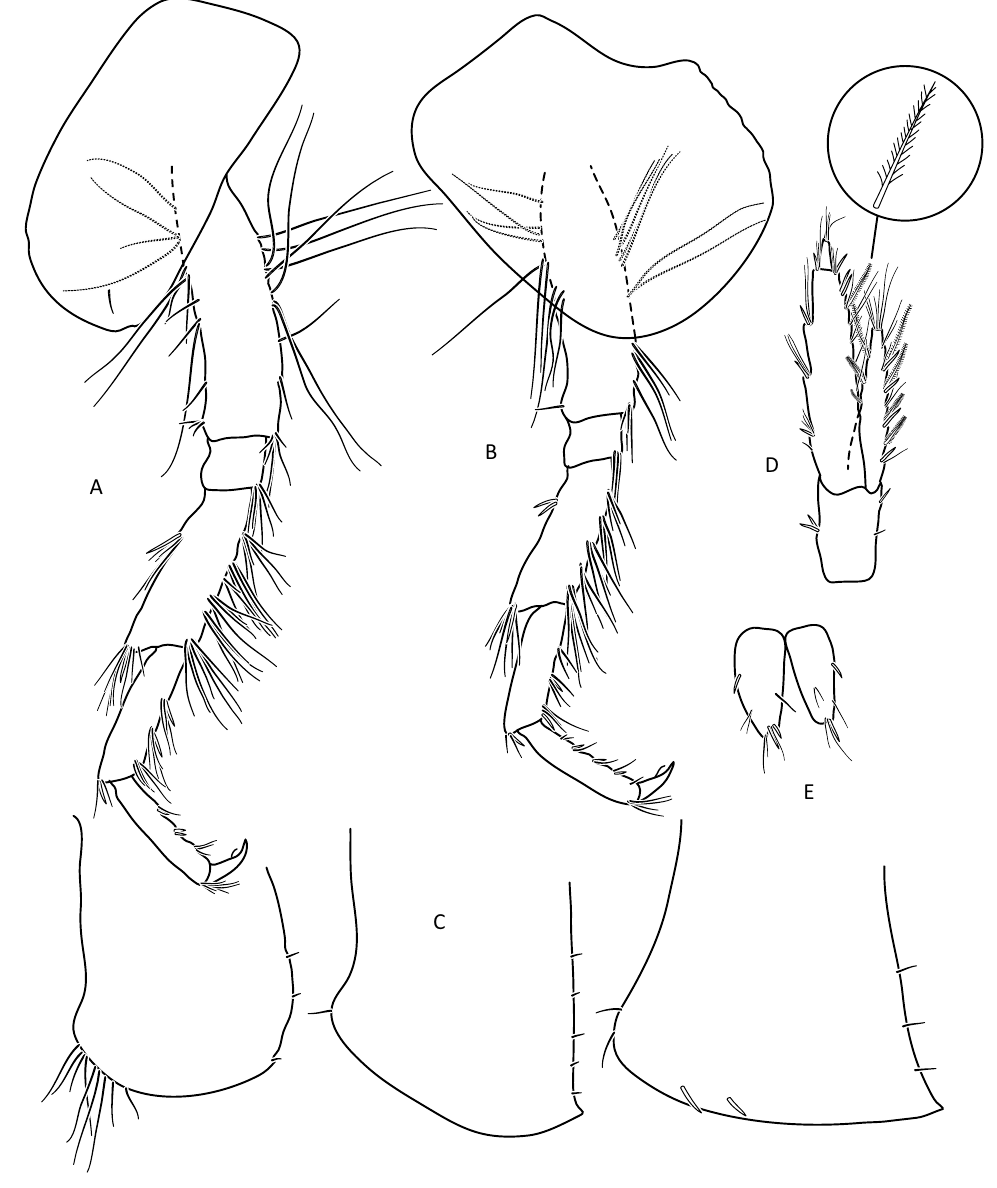
Figure 14. Gammarus tatrensis , female—12 mm. ( a ) epimera I-III, ( b ) urosome, ( c ) uropod 3, ( d ) telson, ( e ) pereopod 5, ( f ) pereopod 6, ( g ) pereopod